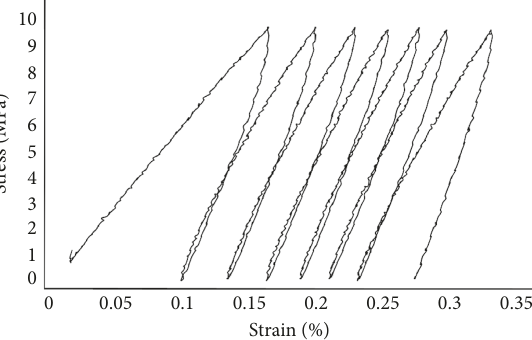
Figure 6: Stress–strain response of control sample.